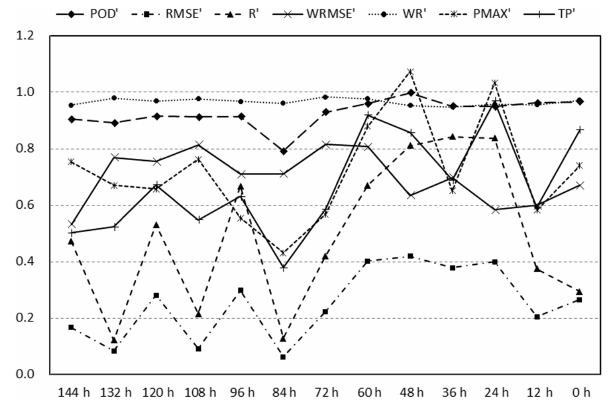
Figure 7. Spatial values of the verification metrics for the WRF spin-up experiments, calculated over 18h periods and over domain three. Case 6 employs an initial spin-up time of 12h; Case 8 em- ploys a spin-up time of 0h; and from Case 9 to Case 19, the spin-up time is increased from 24 to 144h by every